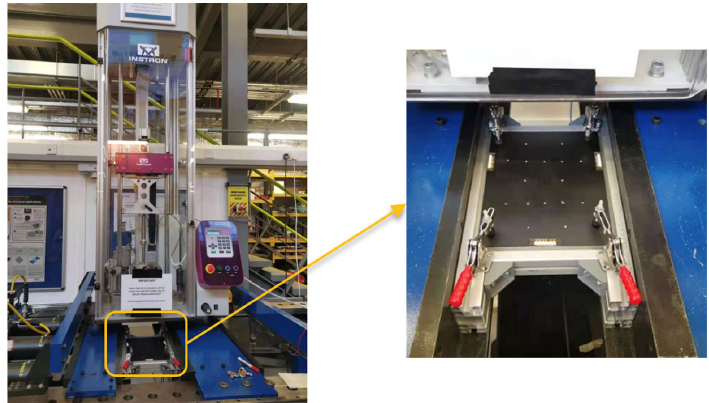
Figure 13. INSTRON CEAST 9350 drop tower for the impact test.